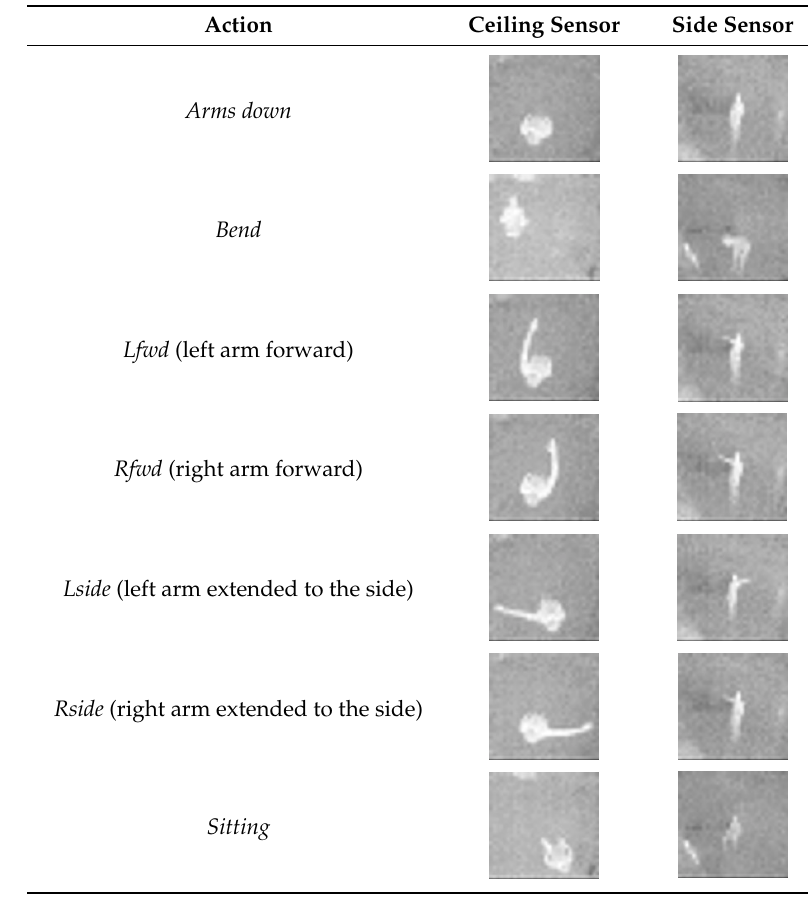
Table 2. Thermal frame examples from the ceiling and side sensors.